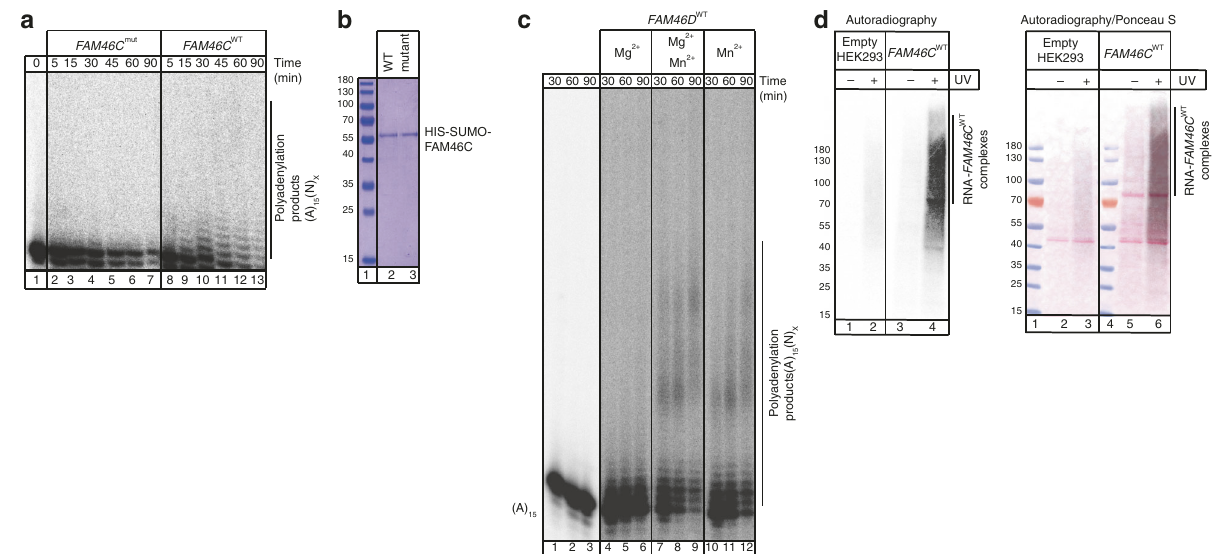
Fig. 1 FAM46C interacts with RNA and is an active RNA poly(A) polymerase in vitro and in vivo. a Recombinant FAM46C WT (lanes 8 – 13), but not its catalytic mutant FAM46C mut (lanes 2 – 7), displays poly(A) polymerase activity in vitro. Reaction products (using 32 P-labeled (A) 15 as substrate) were separated in denaturing PAGE gels and visualized by autoradiography. b SDS-PAGE analysis of recombinant FAM46C WT and its catalytic mutant FAM46C mut . c FAM46D WT is an active poly(A) polymerase in vitro and requires Mn 2+ ions for its activity. Puri fi ed protein was incubated with 32 P-labeled (A) 15 primer in the presence of ATP and divalent cations as follows: Mg 2+ (lanes 4 – 6), both Mg 2+ /Mn 2+ (lanes 7 – 9), or Mn 2+ (lanes 10 – 12). Control RNAs co-puri fi ed with FAM46C WT GFP from HEK293 cells stably expressing the fusion protein (lanes 3 – 4) and from control empty cells (lanes 1 –